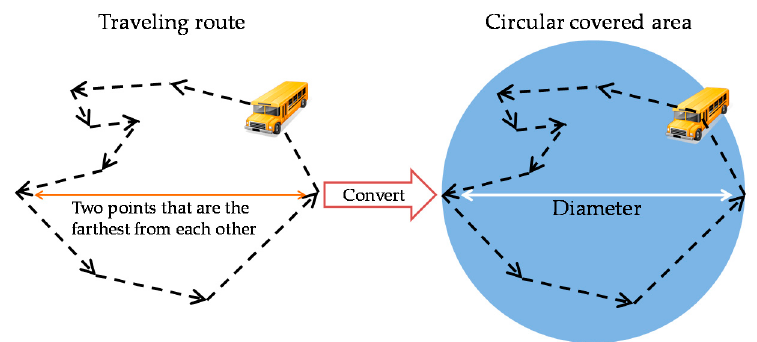
Figure 4. Example of generating a circular covered area.